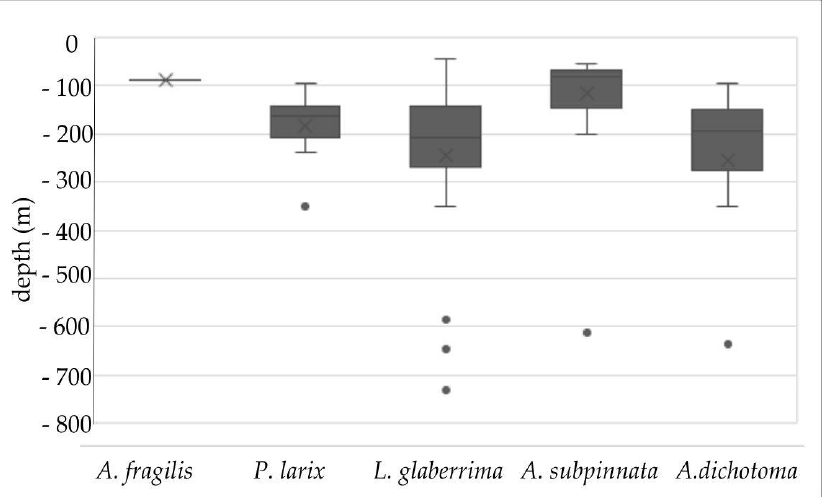
Figure 3. Bathymetric distribution of five black corals in the Italian seas (Outliers are marked with circles and the mean with x